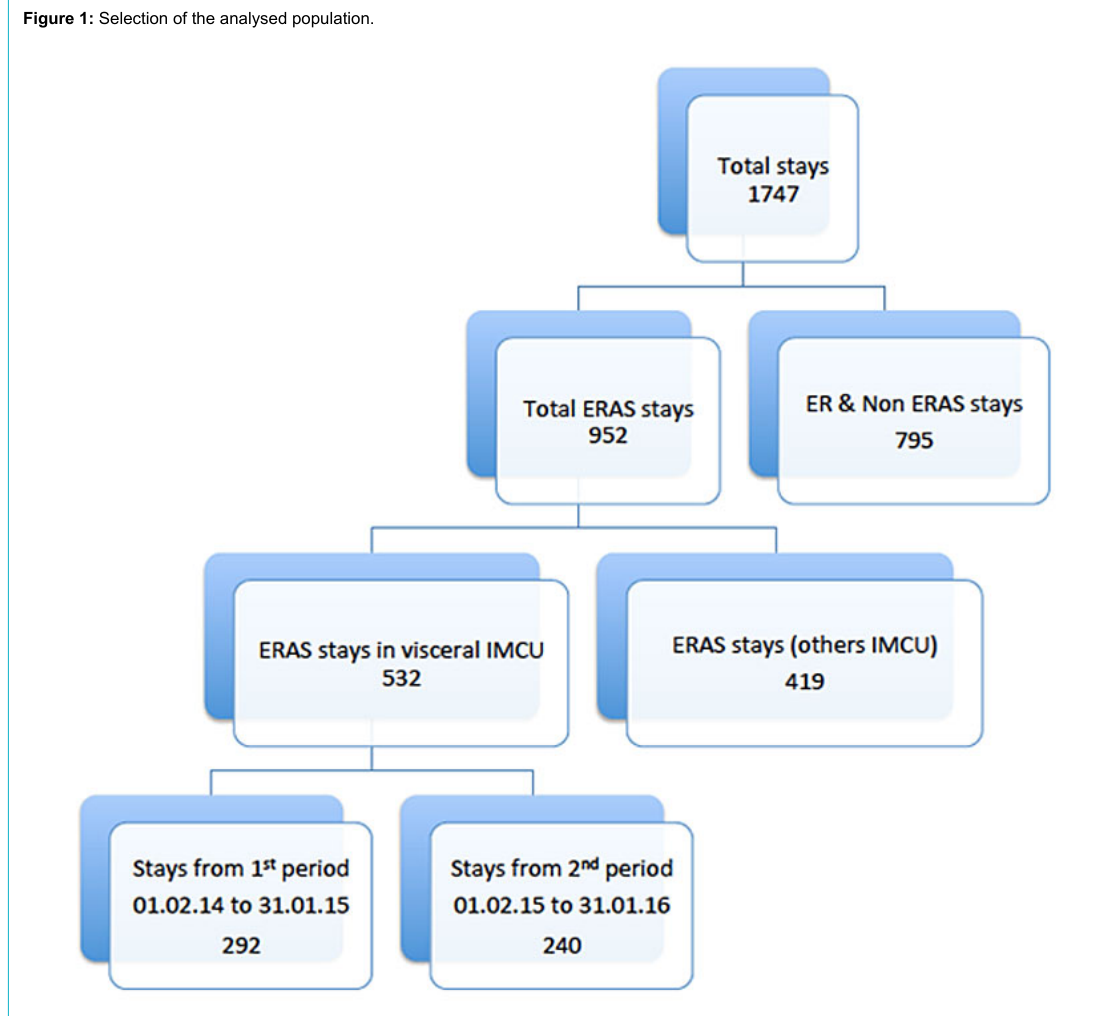
Figure 1: Selection of the analysed